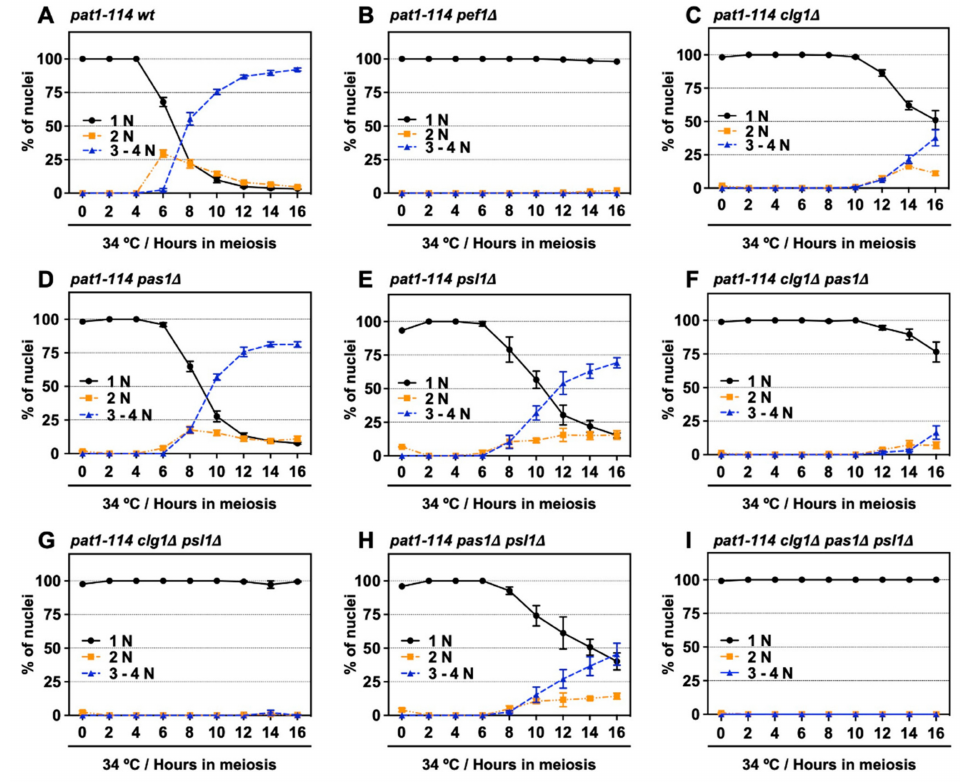
Figure 4. Double deletion of clg1 and psl1 strongly suppresses meiotic progression. ( A – I ) pat1-114 wt (FY7052) ( A ), pat1-114 pef1 ∆ (MS030) ( B ), pat1-114 clg1 ∆ (MS105) ( C ), pat1-114 pas1 ∆ (MS106) ( D ), pat1-114 psl1 ∆ (MS107) ( E ), pat1-114 clg1 ∆ pas1 ∆ (MS155) ( F ), pat1-114 clg1 ∆ psl1 ∆ (MS119-1) ( G ), pat1-114 pas1 ∆ psl1 ∆ (MS156) ( H ) and pat1-114 clg1 ∆ pas1 ∆ psl1 ∆ (MS126-2) ( I ) were nitrogen-starved for 14–16 h. Synchronous meiosis was induced by shifting the cultures from a permissive temperature (25 ◦ C) to a restrictive temperature (34 ◦ C). The cells were fixed at the indicated times and then stained with DAPI. The graph indicates percentages of the G1-pre-meiotic S phase (1N, black solid line), meiosis (2N, orange broken line) and meiosis and ascus (3–4N, blue broken line). At least 100 cells were counted each time. The results are expressed as means ± SEM from three independent